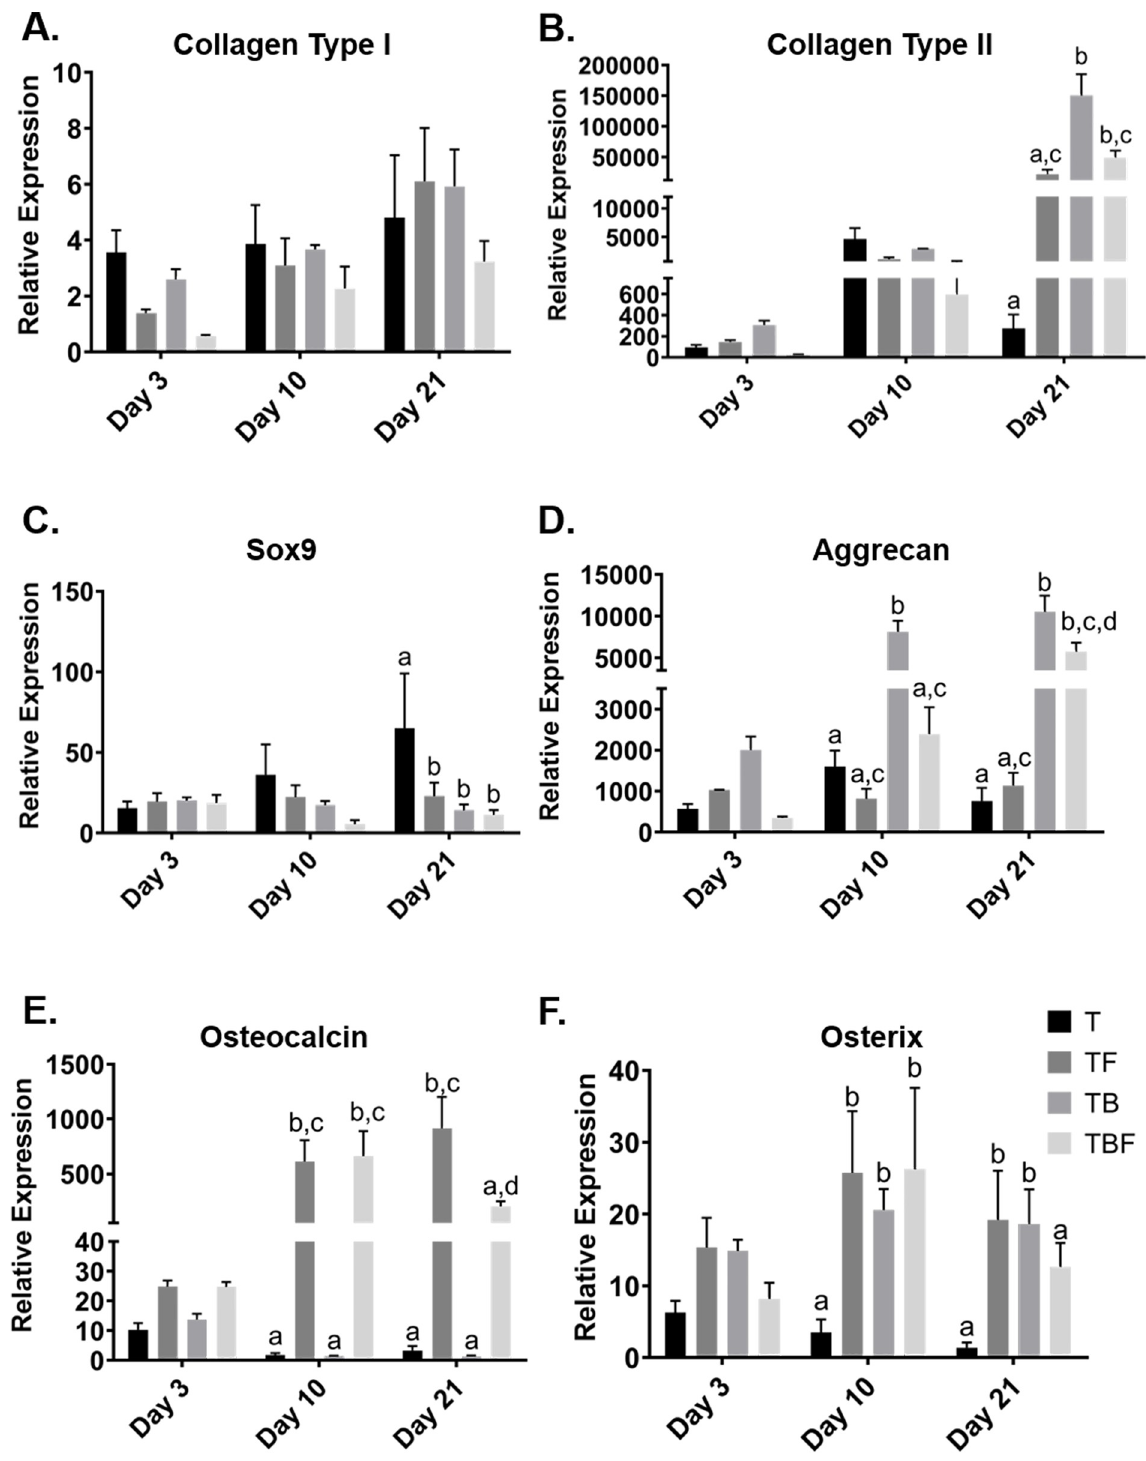
Fig 7. Transcriptional analysis of chondrogenic and osteogenic genes. Constructs were digested in collagenase to liberate cells from adjacent ECM. RNA was isolated for generation of cDNA. Quantitative PCR (qPCR) was performed on day 3, 10, and 21 constructs with relative expression normalized to RNA isolated from cMSCs on day 0 at the time of construct fabrication. A) There was a modest increase in COL1A1 (Collagen Type I) expression over time. B) COL2A (Collagen Type II) expression was significantly increased at day 21, with the greatest expression in cultures containing BMP-2 and/or bFGF. C) There was a modest increase in SOX9 expression over time, with a significantly